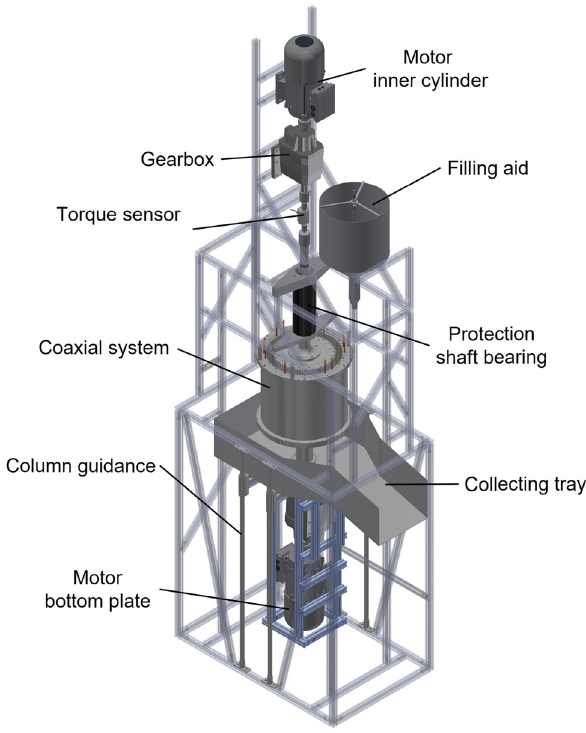
Figure 4: ACCR setup.